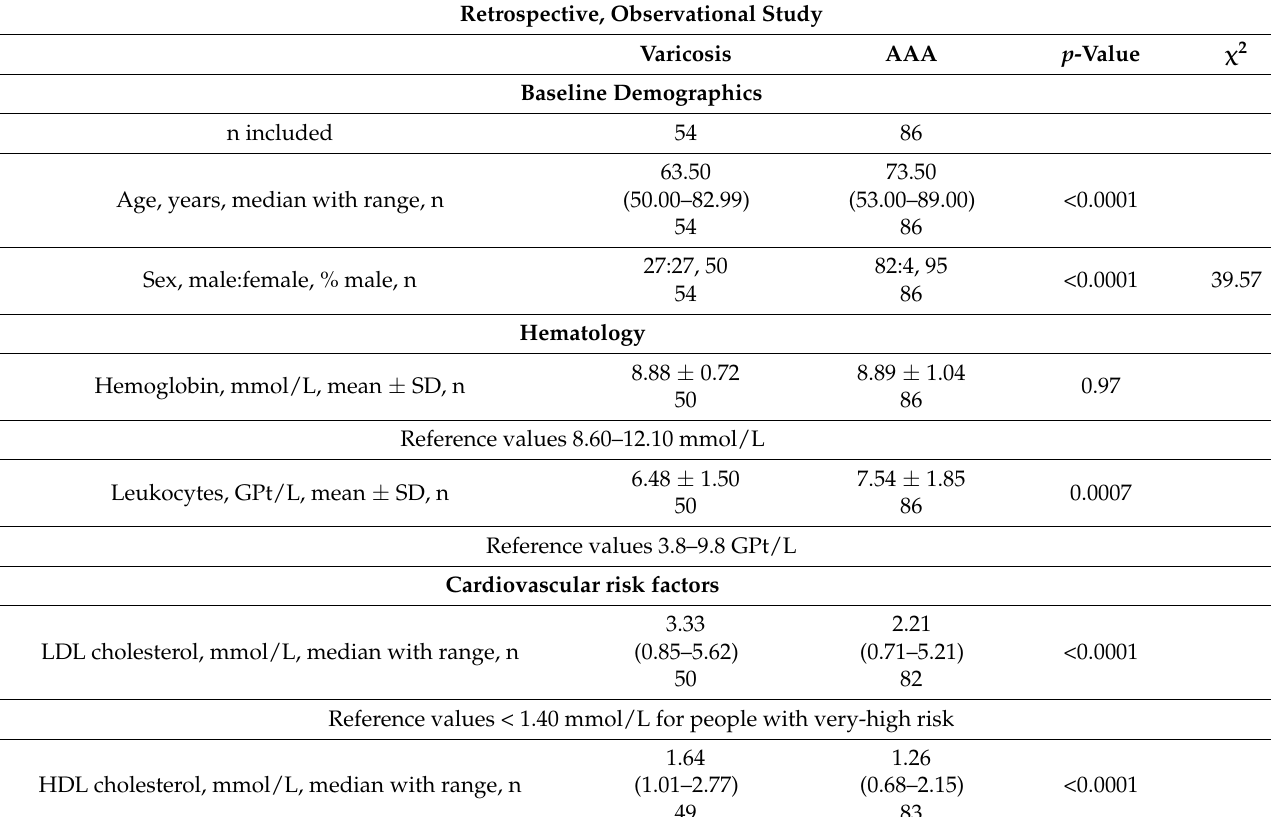
Table 2. Clinical characteristics in patients with abdominal aortic aneurysm (AAA) and venous vessel varicose for the analysis of serum and plasma